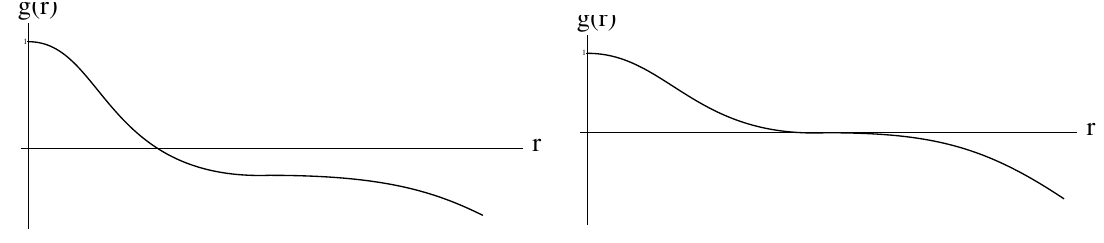
Figure 2. Metric function with the inflection point ( left ) and with the triple-horizon ( right